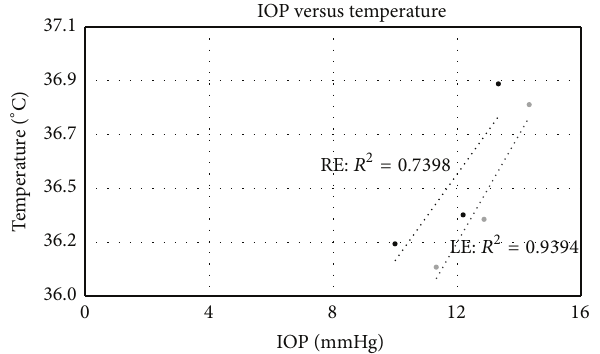
Figure 3: Graph of the relationship between average corneal temperature ( 𝑦 -axis) and IOP ( 𝑥 -axis) for the right eye (RE: closed, black circles) and left eye (LE: closed, grey circles). The correlation coefficient for a linear correlation is reported.